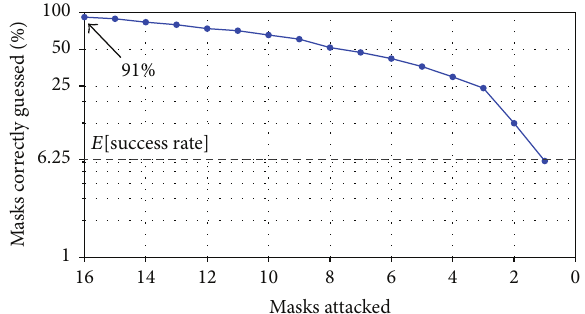
Figure 3: Mask recovery success rate as a function of number of masks